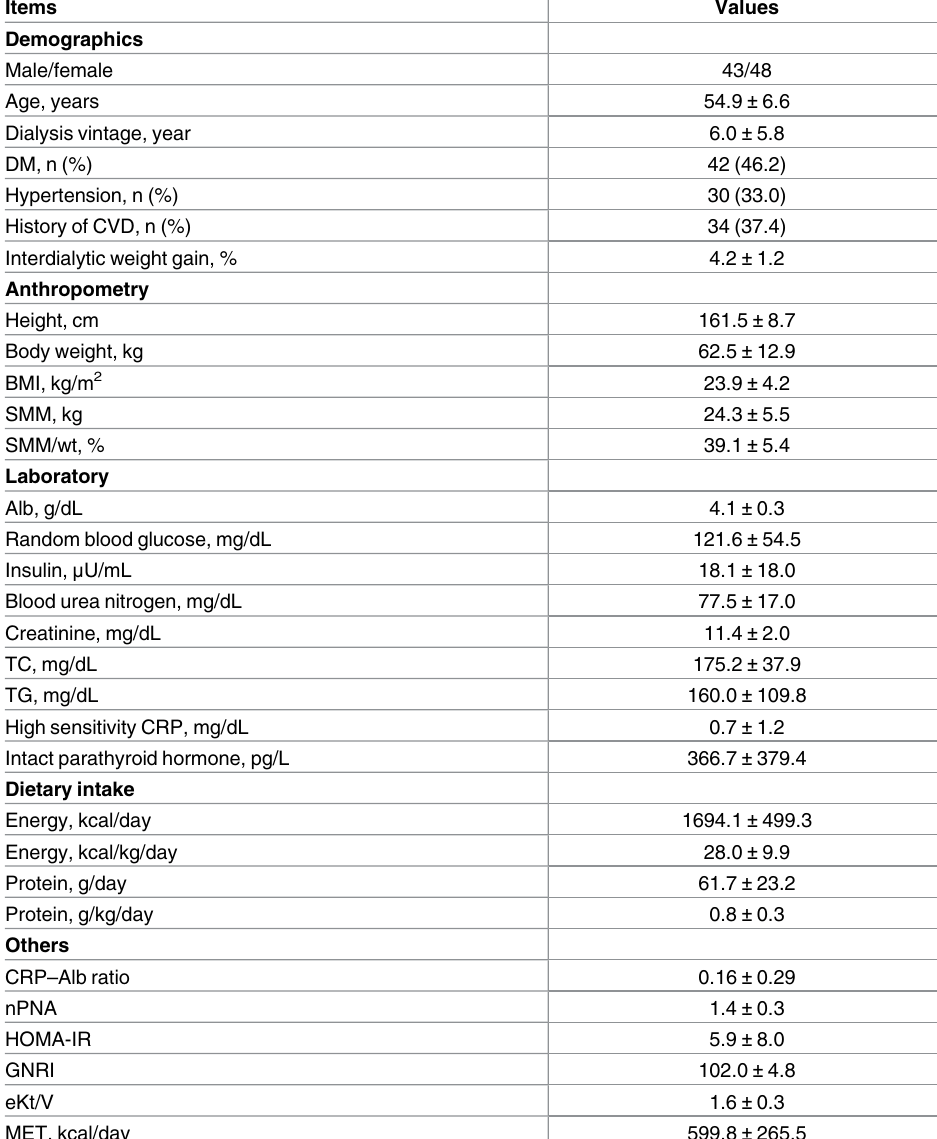
Table 1. Baseline demographics, anthropometric, laboratory, and dietary features of the study popu- lation (n = 91) 1 . Items